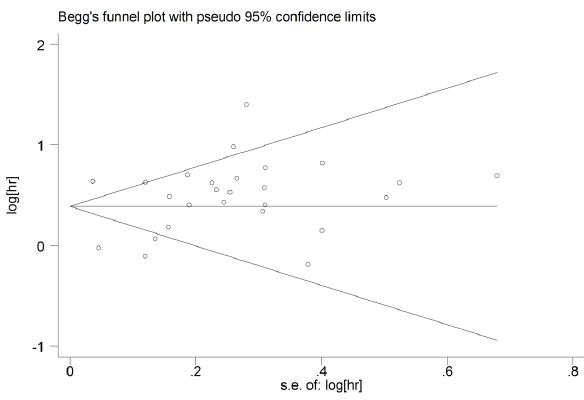
Figure 4. Funnel plots of studies included in the meta-analysis.